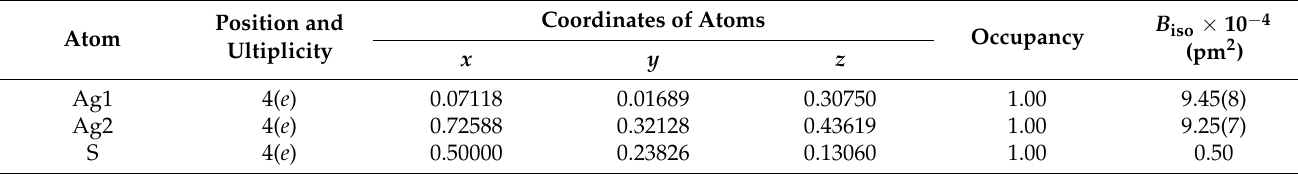
Table 1. Refined crystal structure of synthesized silver sulfide with monoclinic (space group P 2 1 / c